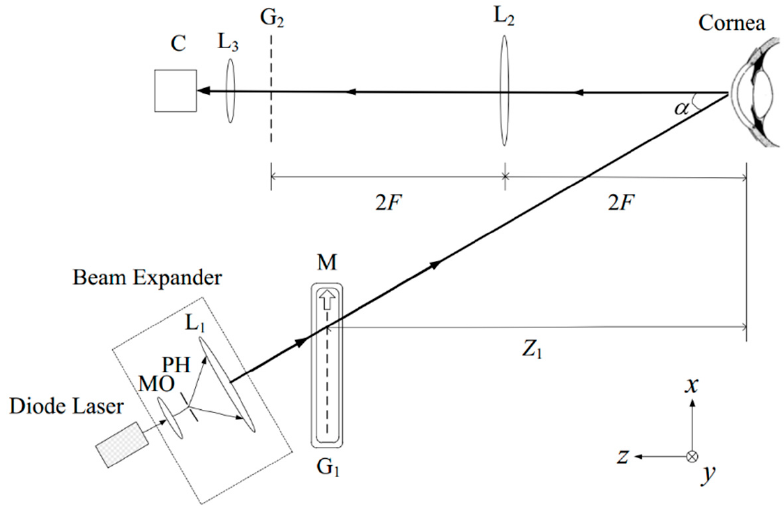
Figure 9. Setup for measuring the corneal surface based on the Moiré method [67].